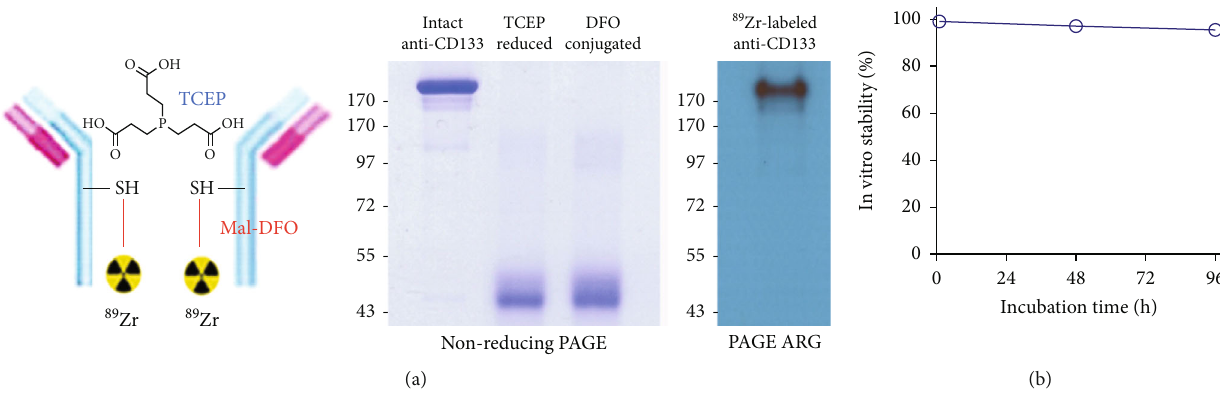
Figure 1: Deferoxamine conjugation and 89 Zr labeling of anti-CD133 IgG. (a) Diagram of 89 Zr-CD133 IgG (left), nonreduced SDS polyacrylamide gel electrophoresis (PAGE) of unmodi fi ed, TCEP-reduced, and DFO-conjugated anti-CD133 IgG (middle), and autoradiography of a native 89 Zr-CD133 IgG PAGE (right). (b) In vitro stability of 89 Zr-CD133 IgG assessed by radio-iTLC after incubation in PBS at 37 ° C for 96 hours